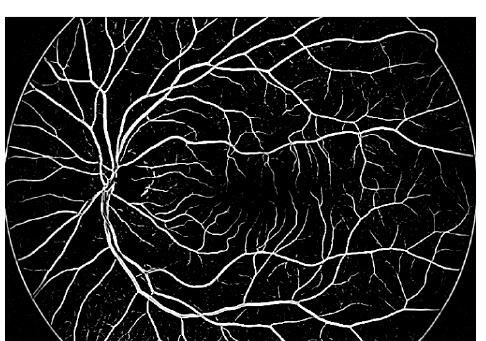
Figure 4.a. Input image